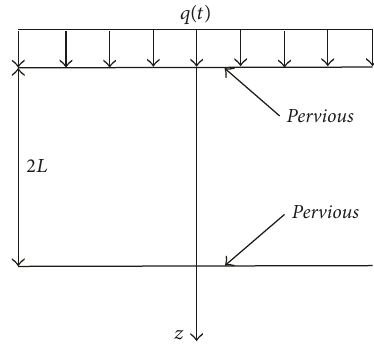
Figure 2: 1D foundation